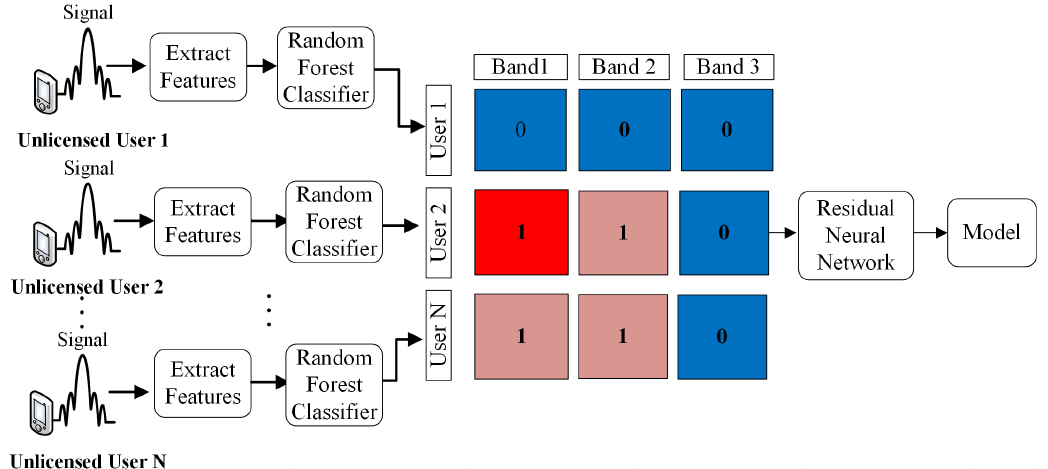
Figure 1. Proposed system for generation of the CSS